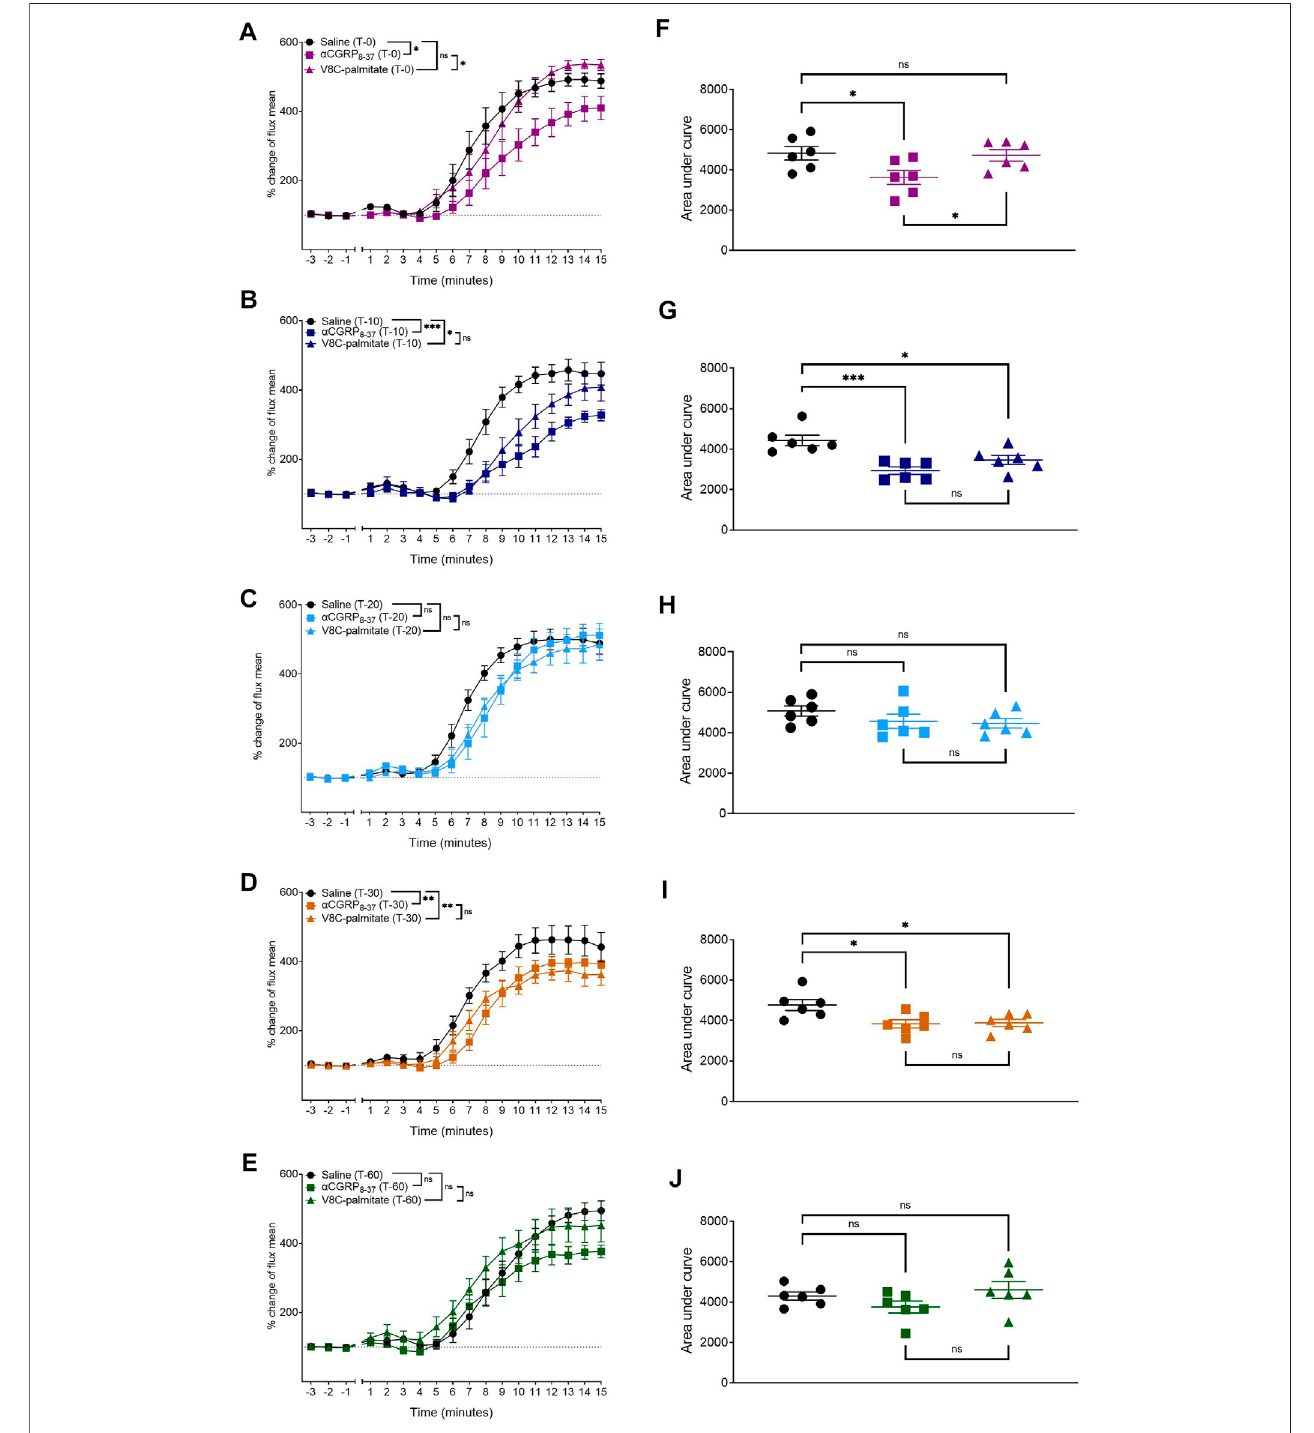
FIGURE 9 | Comparison between α CGRP 8-37 and V8C-palmitate for antagonism onset of CGRP action in vivo . α CGRP 8-37 (960 nmol/kg) and V8C-palmitate (960 nmol/kg) were administered at 0 min (A,F) , 10 min (B,G) , 20 min (C,H) , 30 min (D,I) and 60 min (E,J) prior to anesthesia and capsaicin application. ns p > 0.05, * p < 0.05, ** p < 0.01, *** p < 0.001. Each treatment group comprised six mice with corresponding saline controls.